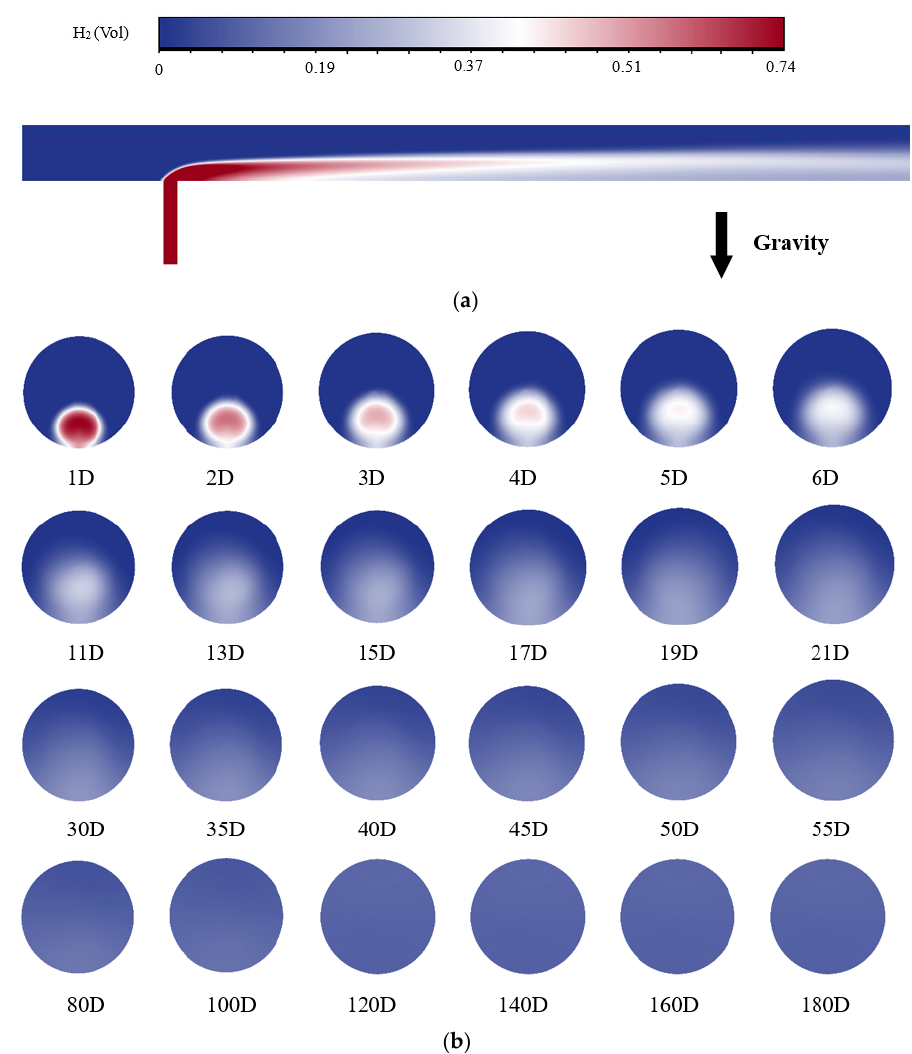
10m/s v = , = 10 m/s, 4 4 CH